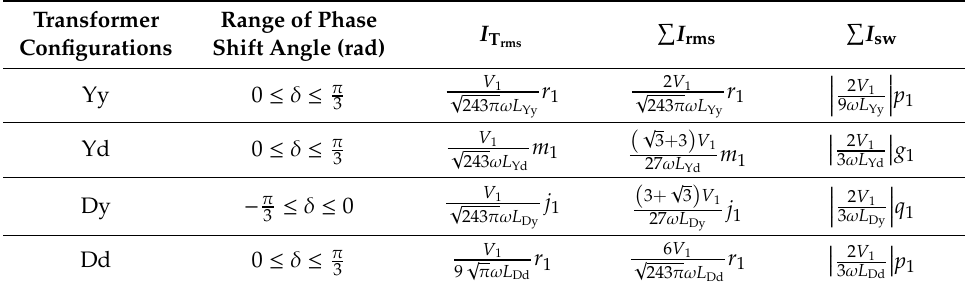
Table 5. Transformers RMS current and switch RMS and transient